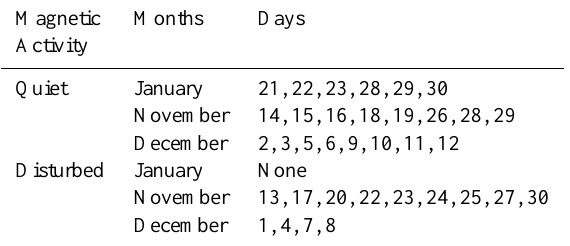
Table 1. Data classification according to the magnetic activity around the South Hemisphere summer solstice in